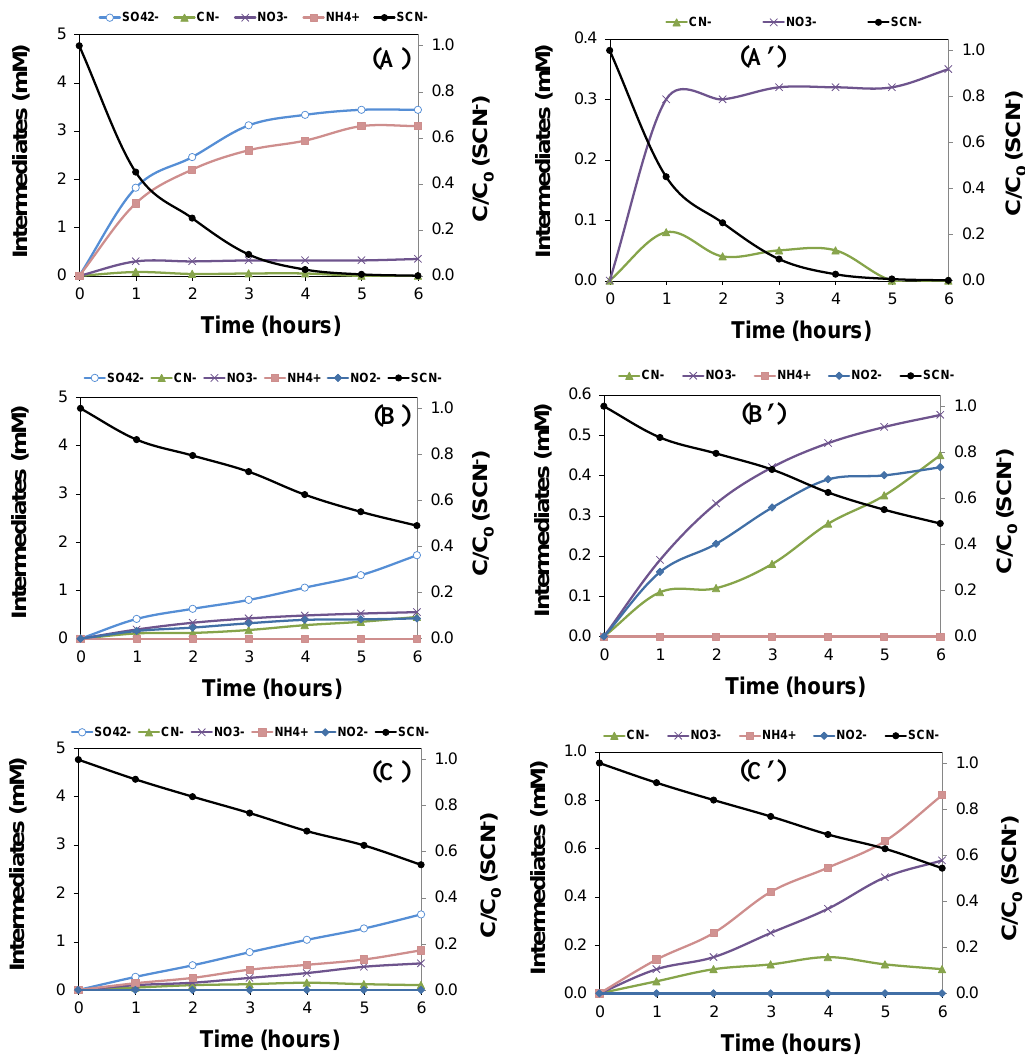
Figure 4. Evolution of the concentration of thiocyanates (right axis) and intermediates (left axis) upon illumination of a synthetic solution of 200 mg/L of potassium thiocyanate with various light sources. ( A , A’ ) UVC lamp; ( B , B’ ) UV-Vis lamp; ( C , C’ ) SimSolar lamp (for clarity, plots A, B, and C are magnified in A’, B’, and C’, respectively).